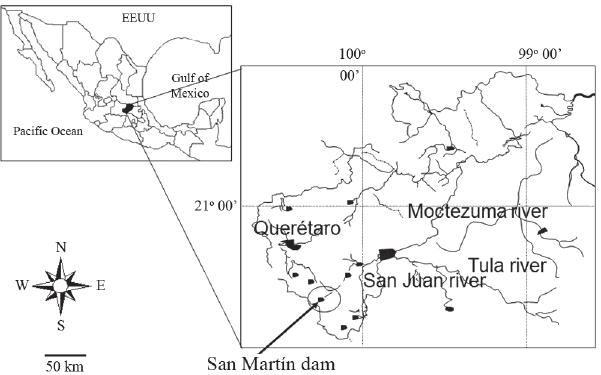
Fig. 1. Environmental parameters during a hydrological cycle in San Martín